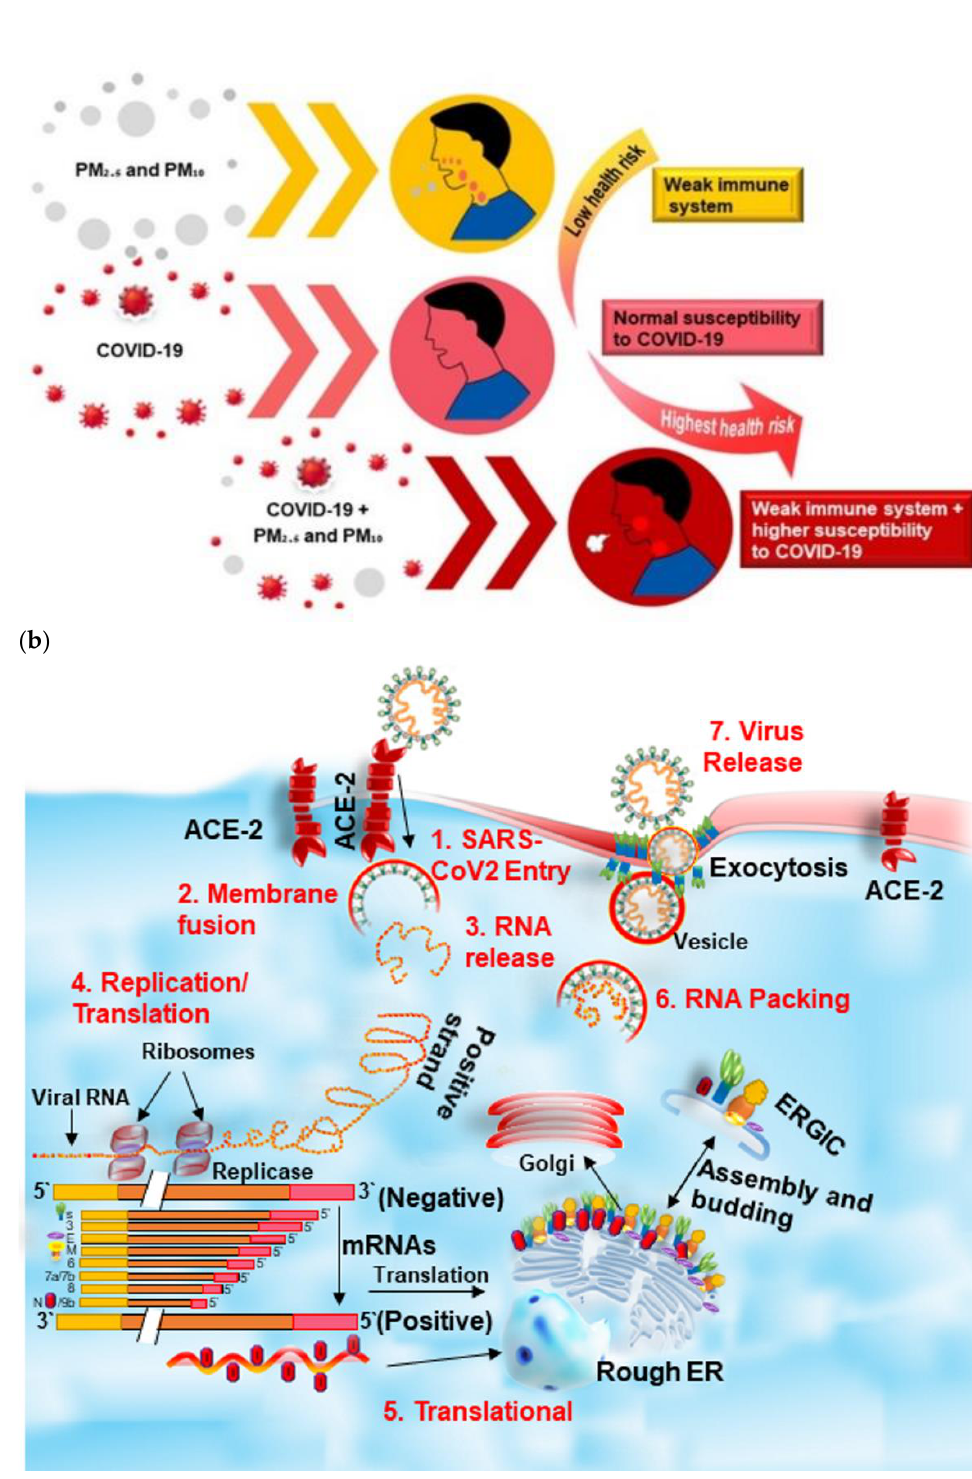
Figure 6. ( a ) COVID-19 health risk in the presence and absence of PM pollution; ( b ) the process of SARS-CoV-2 pathogenicity based on replication attachment.